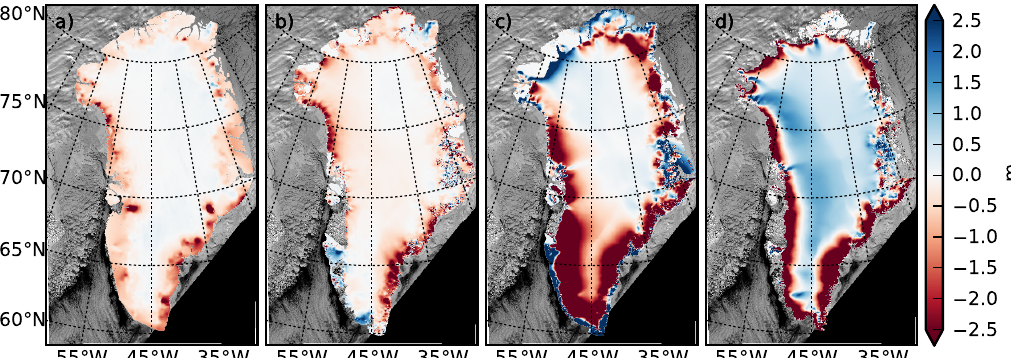
Fig. 6. Observed and modeled surface elevation change from October 2003 to November 2009. (a) ICESat (Sørensen et al., 2011). (b) “constant-climate” hindcast. (c) “paleo-climate” hindcast. (d) “flux-corrected” paleo-climate hindcast. Values are in meters.